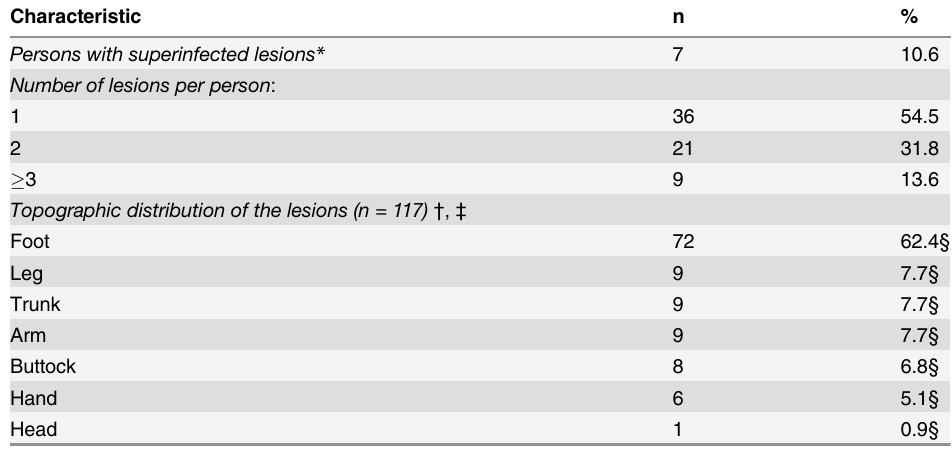
Table 2. Clinical characteristics of study participants with HrCLM (Hookworm-related cutaneous larva migrans) (N = 66). Characteristic n